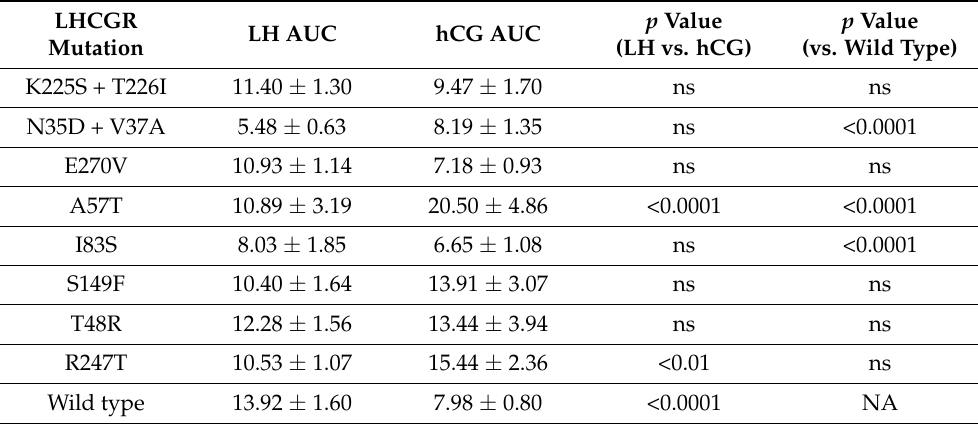
Table 3. LH and hCG area under the curve (AUC) calculated from ERK1/2 activation kinetic curves (two-way ANOVA and Sidak’s correction for multiple test; means ± SEM, relative units; n = 8). NA = not assessed; ns = not significantly